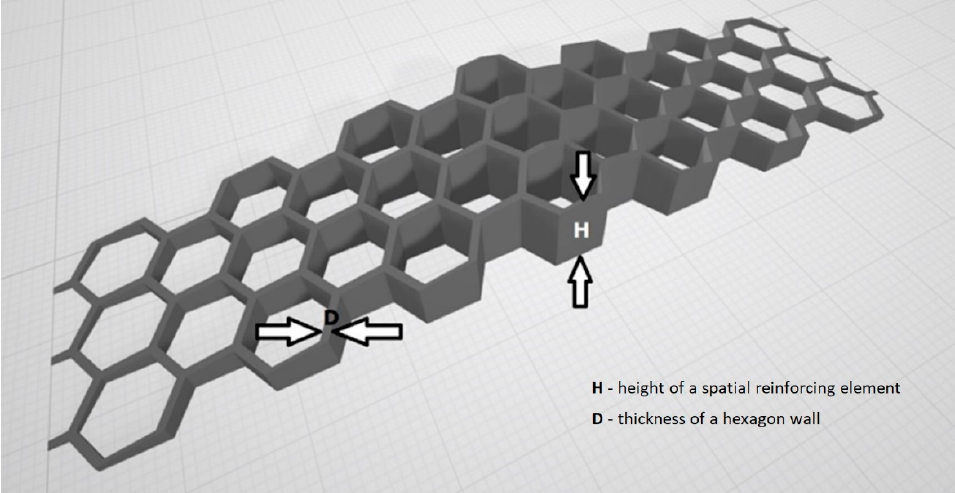
Figure 3. General view of the designed spatial reinforcing element.